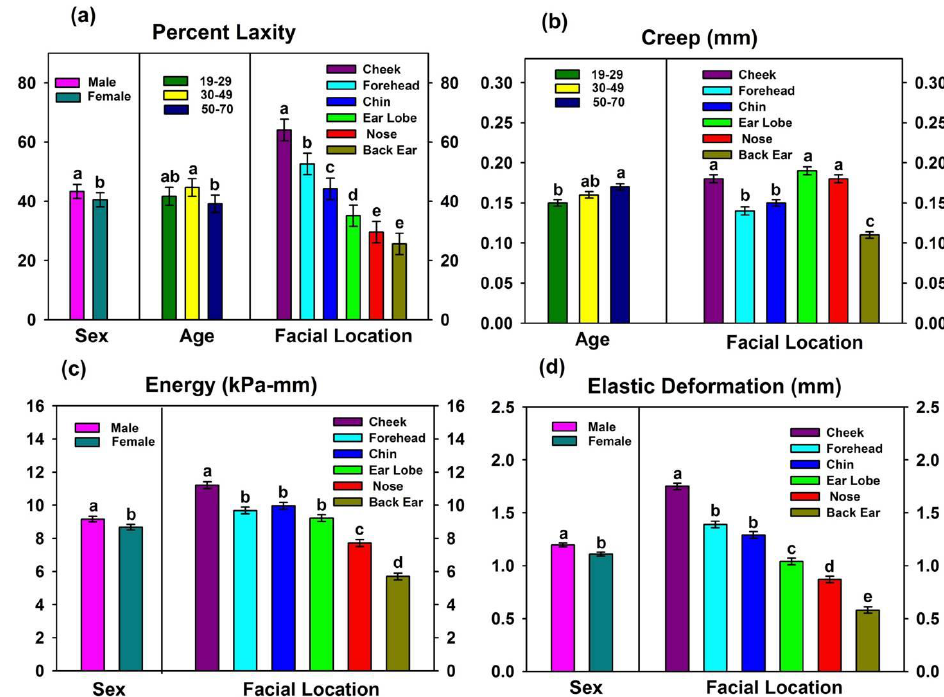
Figure 3. Main effects of facial location, gender, and age on ( a ) laxity, ( b ) creep, ( c ) energy absorption, and ( d ) elastic deformation. Groups denoted with the same lower-case letters are not significantly different from each other ( p ≥ 0.05). Comparisons are only within each main effect. Error bars represent standard error of means. Table 3. Comparisons of stiffness and percent elasticity measured at different facial locations (mean ± se) *. Facial Location Stiffness (kPa/mm) Back of